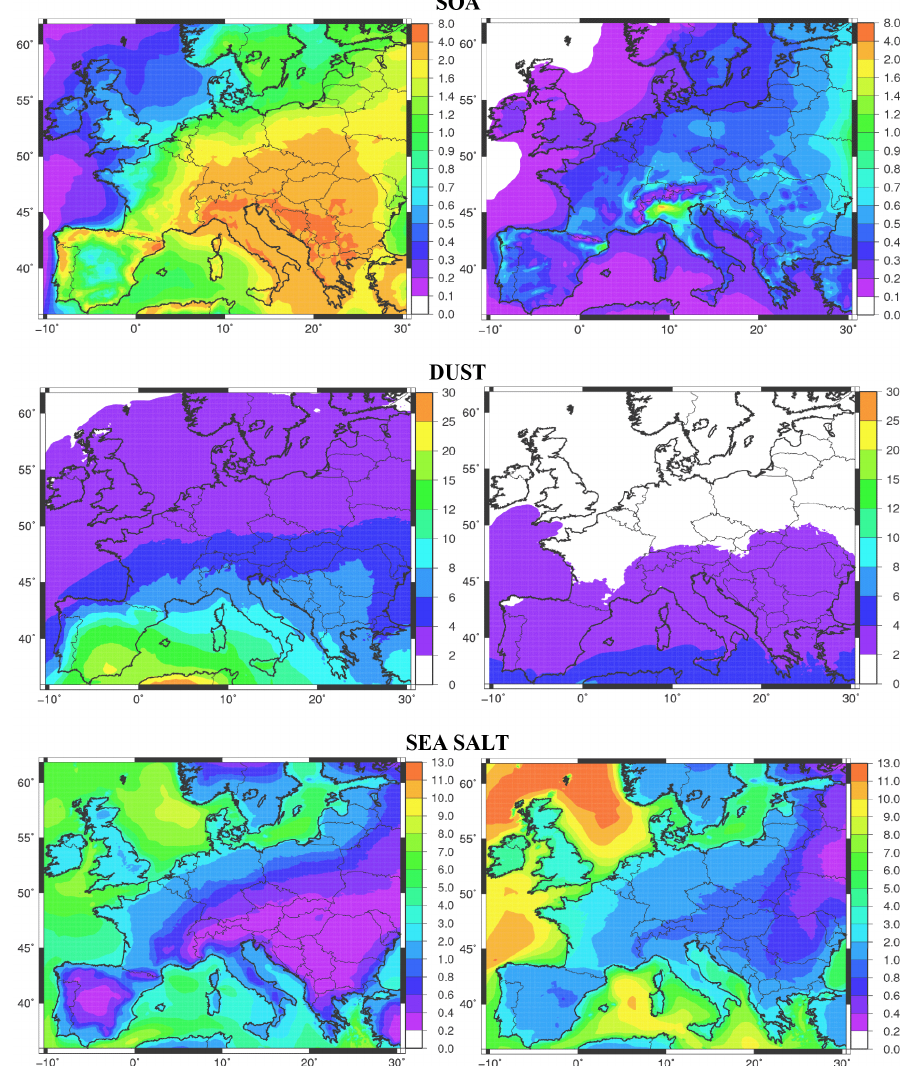
Figure 9. Modelled SOA, dust and sea salt (µgm − 3 ) concentrations fields calculated for the summer (left) and the winter (right) seasons.